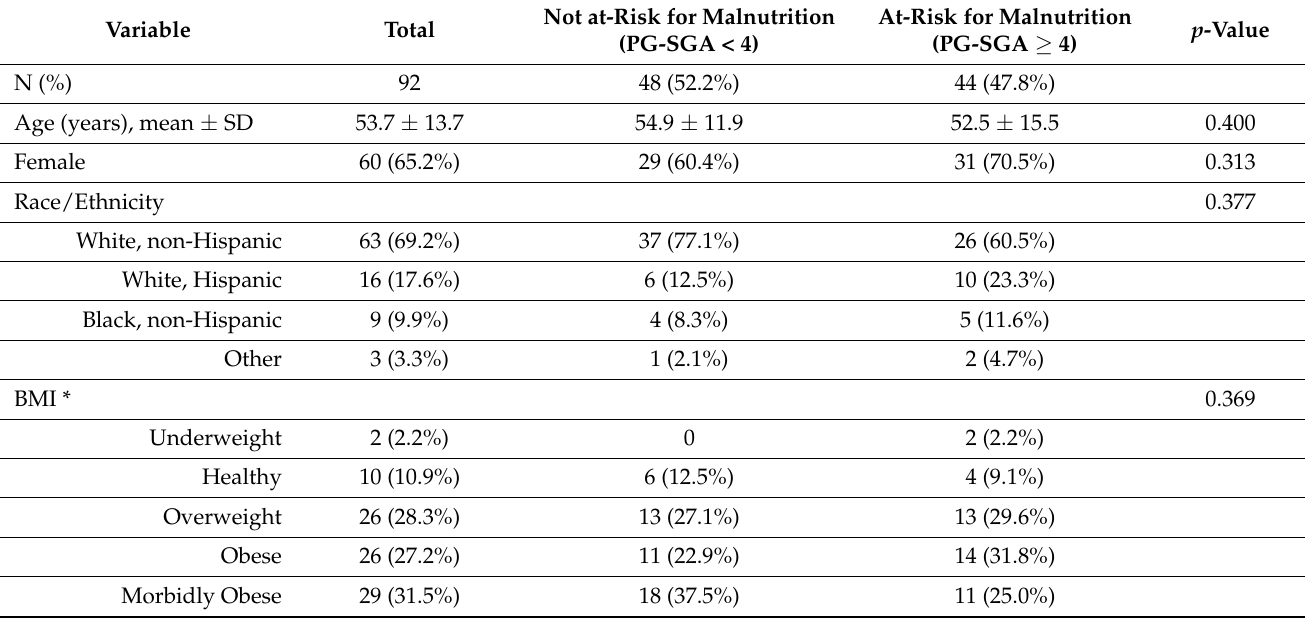
Table 1. Demographic characteristics of the final sample by malnutrition risk α ( n =